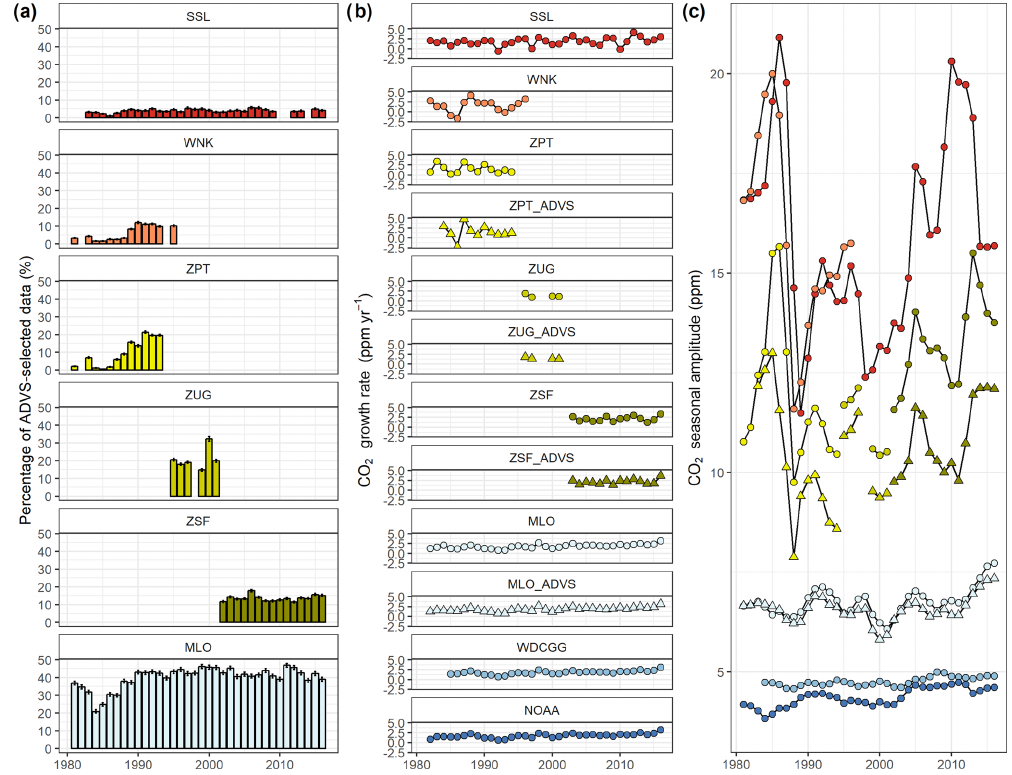
Figure 7. (a) Annual ADVS-selected percentages. (b) Annual CO 2 growth rates and global means from the NOAA and the WDCGG. The calculated growth rates are shown at the beginning of the year. Since the time period starts in 1981, the values of growth rates start in 1982. WDCGG data are only available starting in 1984. (c) Annual CO 2 seasonal